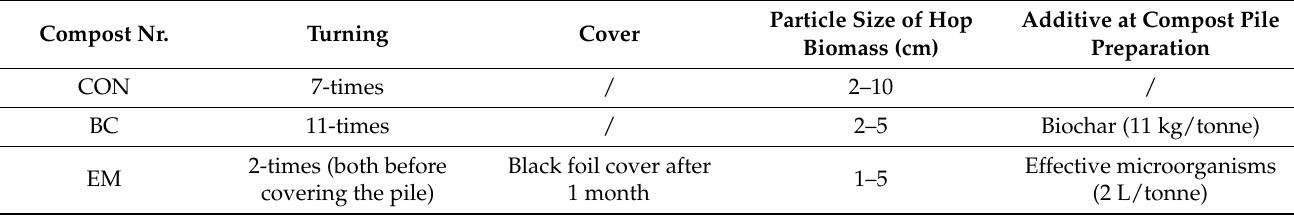
Table 1. Treatment-related composting